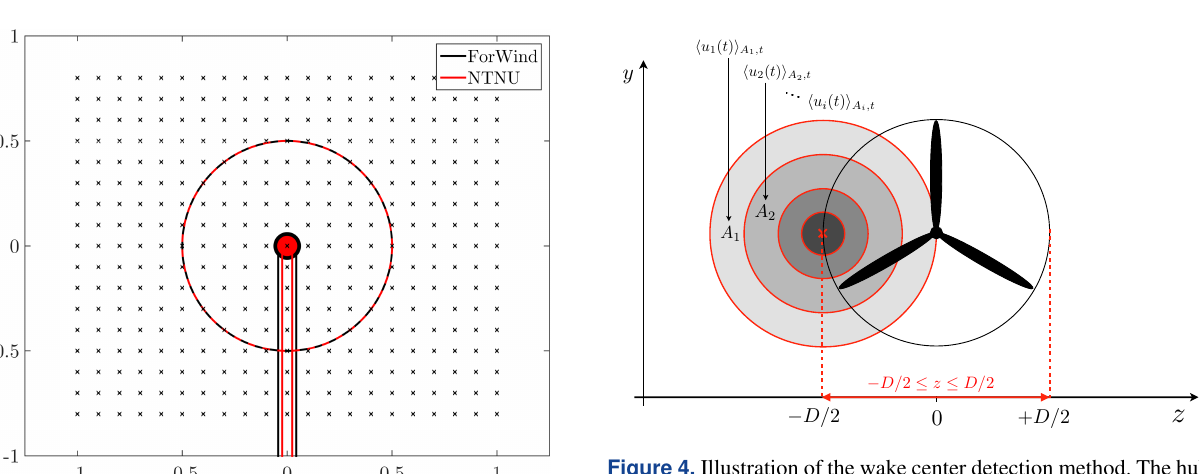
Figure 2. Sketch of the setup, top view. D denotes the respective rotor diameter as listed in Table 1.